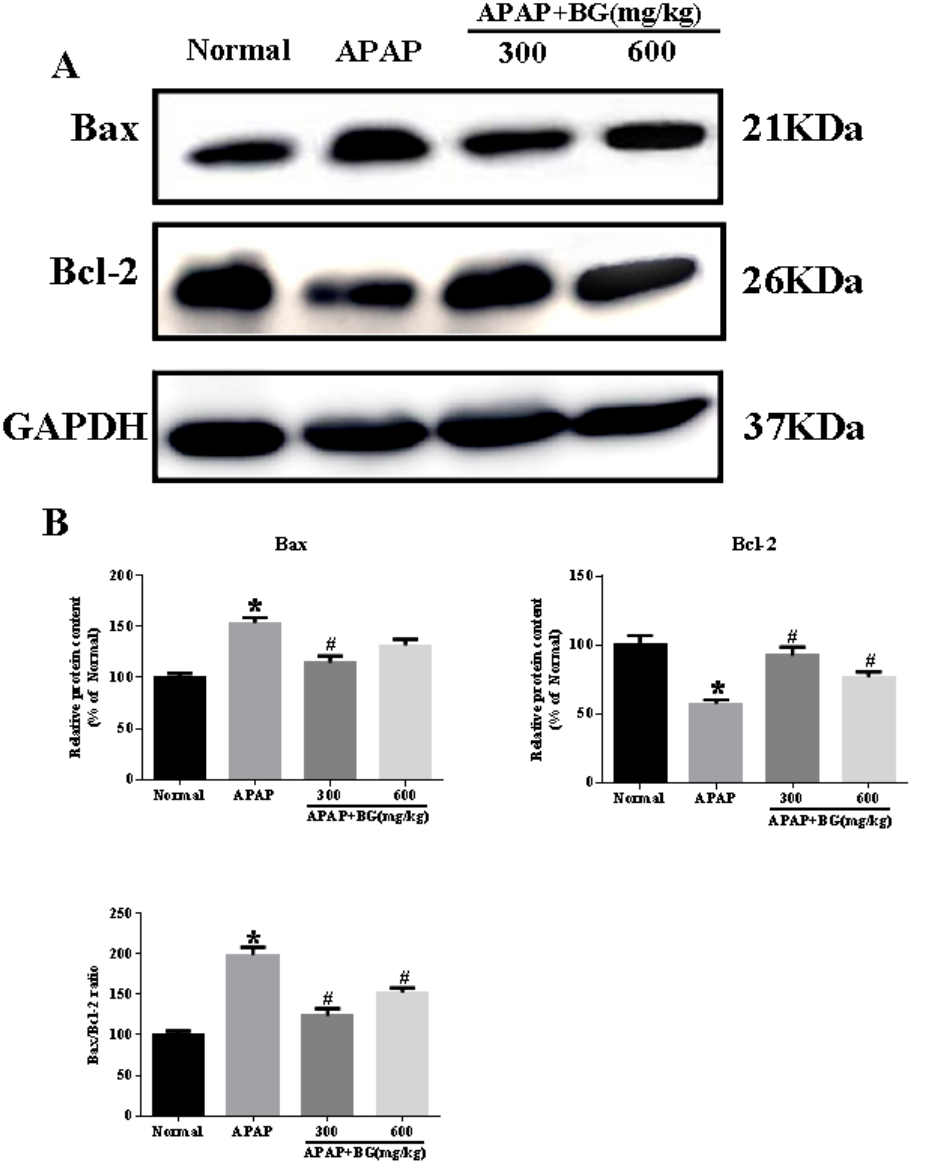
Figure 5. Effects of BG on the protein expression of Bax; and Bcl-2 ( A ); and results are quantified from their band intensities ( B ). The protein expression was examined by western blotting analysis in liver tissues from normal, APAP, APAP + BG (300 mg/kg), and APAP + BG (600 mg/kg) group animals. All data were expressed as mean ± S.D., n = 8. * p < 0.05 vs. normal group; # p < 0.05 vs. APAP group.